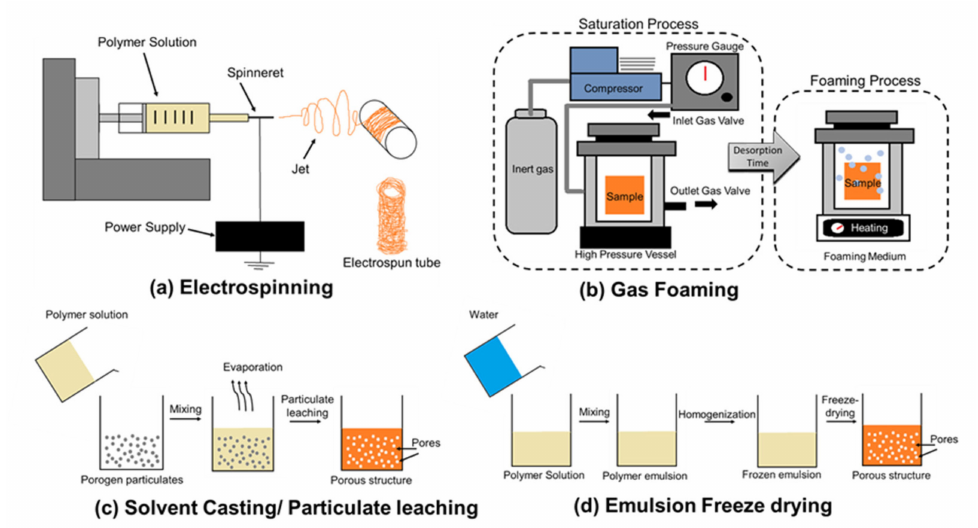
Figure 5. Schematic illustrating methods for sca ff old fabrication. ( a ) Electrospinning of mesh onto rotating mandrel, ( b ) Introducing blowing agent with temperature in the process of gas foaming, ( c ) solvent casting followed by particulate leaching and ( d ) emulsion freeze drying to form porous sca ff olds. Image adapted from